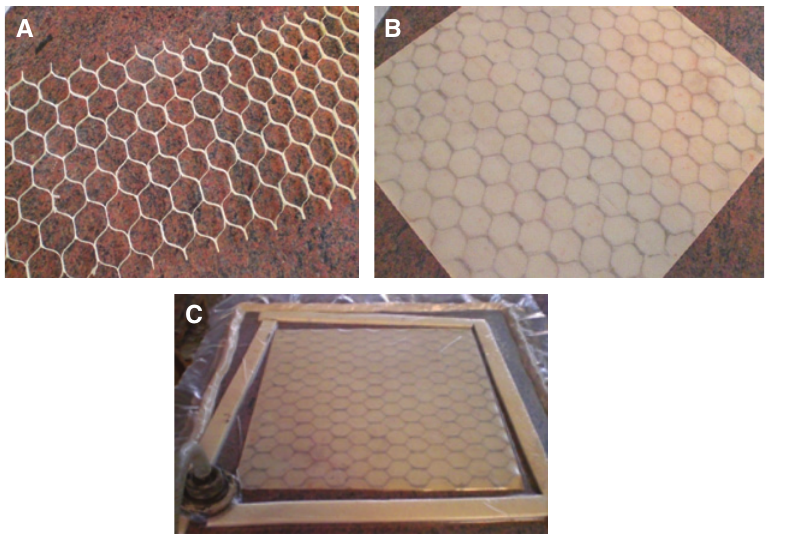
Figure 1 Fabrication of honeycomb sandwich panel. (A) Honeycomb core, (B) honeycomb core with face sheet, (C) honeycomb sandwich panel under